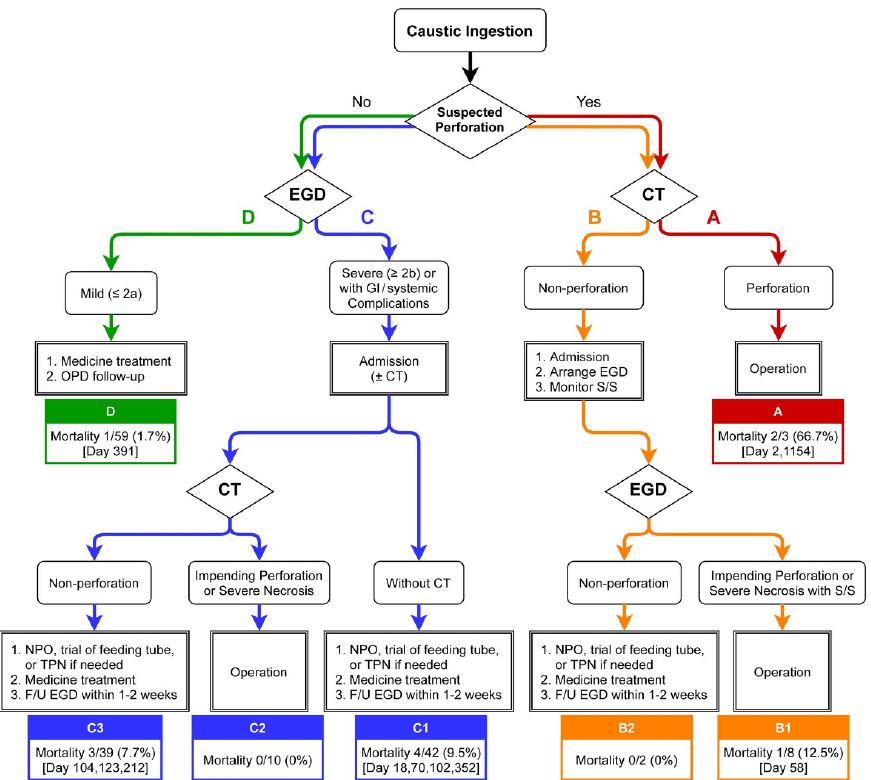
Figure 1. Reported flowchart of patient categorization and management for caustic ingestion used in Linkou Chang Gung Memorial Hospital (CGMH). Abbreviations: CT, computed tomography; EGD, esophagogastroduodenoscopy; F/U, follow-up; GI, gastrointestinal; NPO, nulla per os (nothing by mouth); OPD, out-patient department; S/S, signs/symptoms; TPN, total parenteral nutrition.